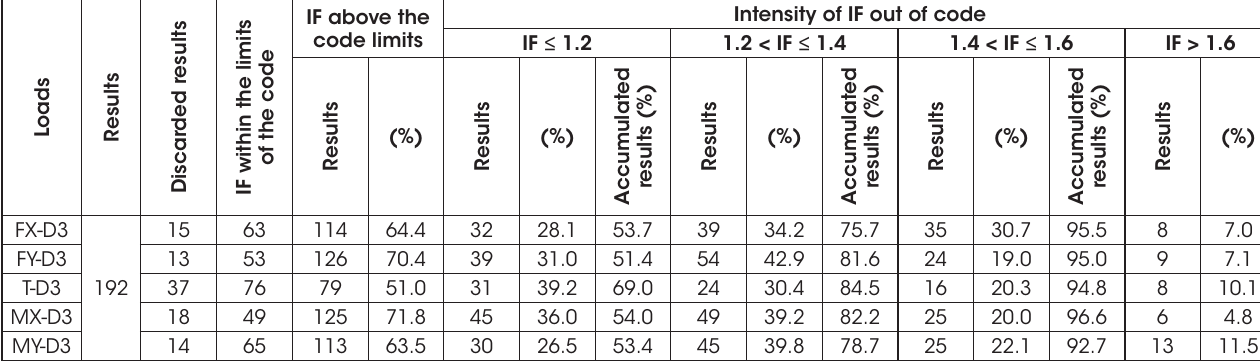
Results for distance